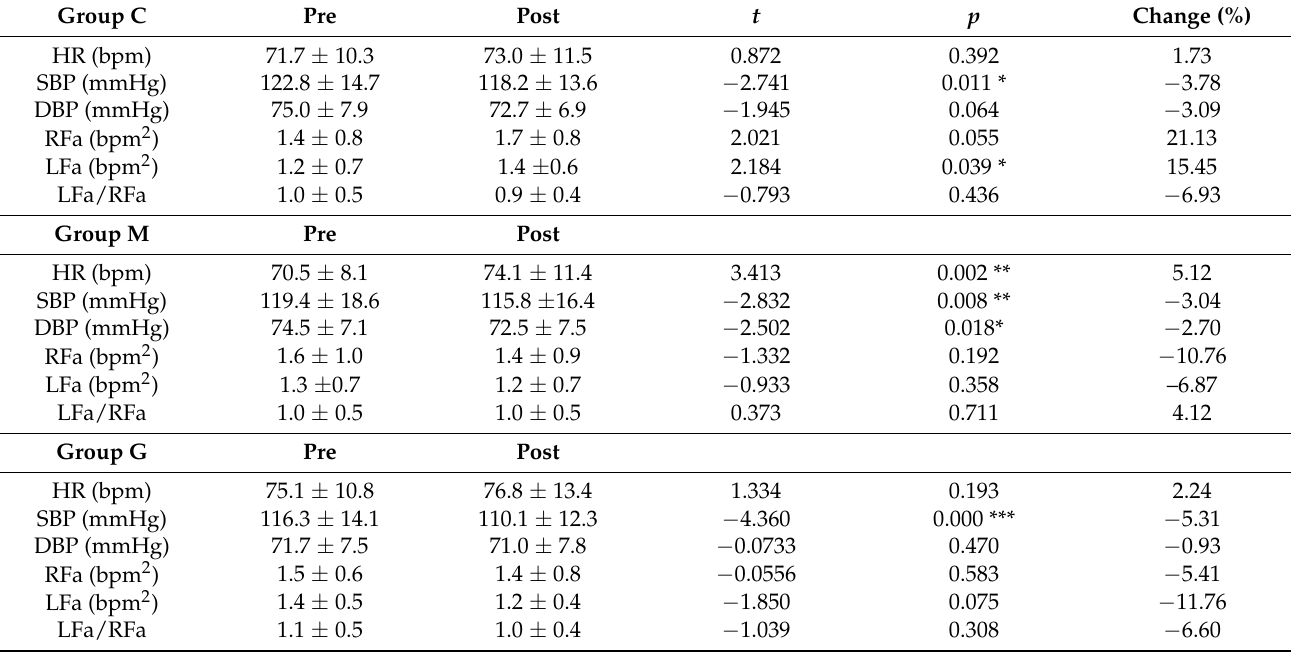
Table 5. Paired-sample t -test results of physiological responses in the three programs.